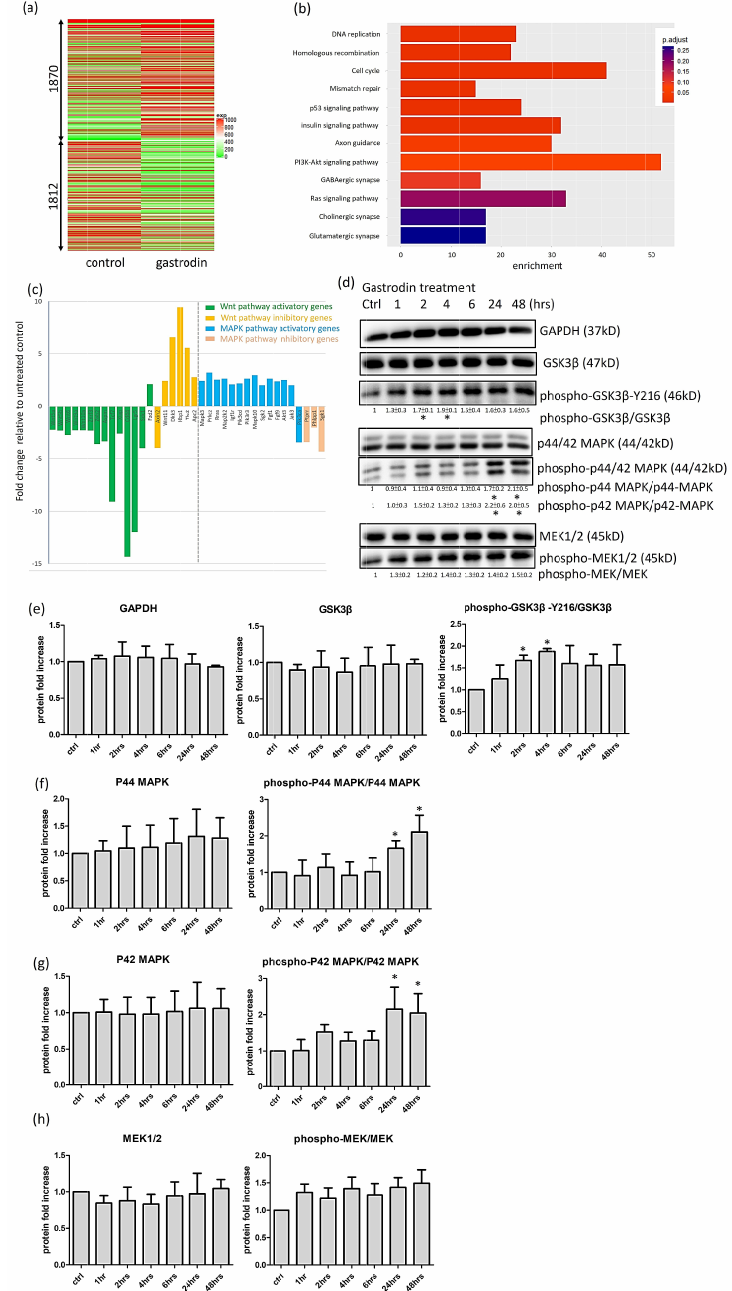
Figure 8. Gastrodin promotes GSK3 β and MAPK pathway activation in SOD1 G93A -NSC34 MN-like cells. ( a ) Dendrogram showing clustering of gastrodin-treated and untreated SOD1 G93A -NSC34 cells based on transcriptional changes detected by RNA-microarray. ( b ) Gene sets enrichment in gastrodin-treated SOD1 G93A -NSC34 cells. ( c ) Graph of expression fold change for Wnt and MAPK signaling-related genes in gastrodin-treated and untreated control SOD1 G93A -NSC34. ( d – h ) Western blotting of GAPDH, GSK3 β , phospho-GSK3 β , MAPK, phospho-MAPK, MEK, and phospho-MEK proteins from gastrodin-treated and untreated (ctrl) SOD1 G93A -NSC34 cells. * p <